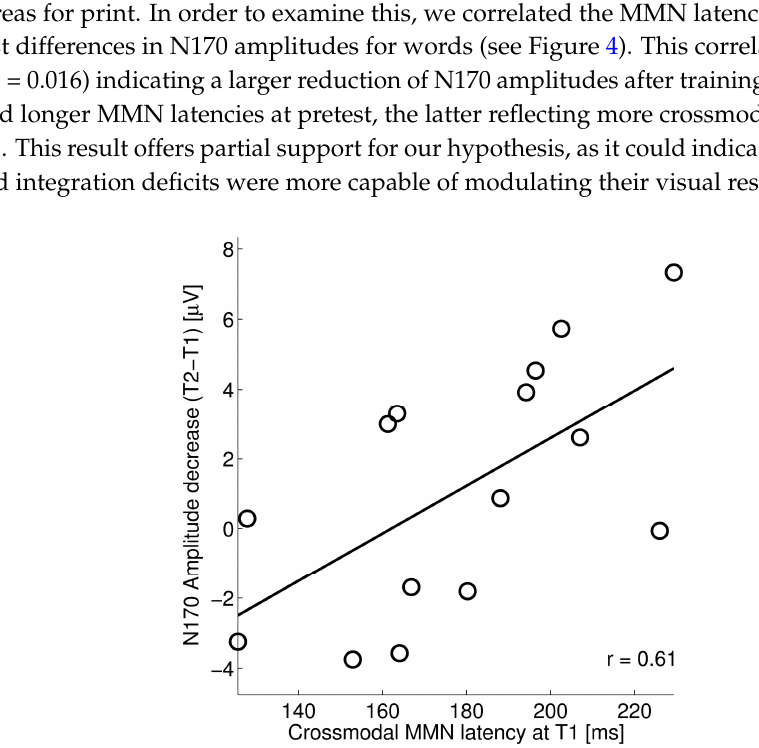
Figure 4. Crossmodal MMN latency at pretest (T1) was related to the N170 amplitude decrease from pretest (T1) to the end of the first part of the training, which was aimed at letter-speech sound integration (T2). A change towards positive values along the y-axis refers to a decrease in the N170 amplitude.